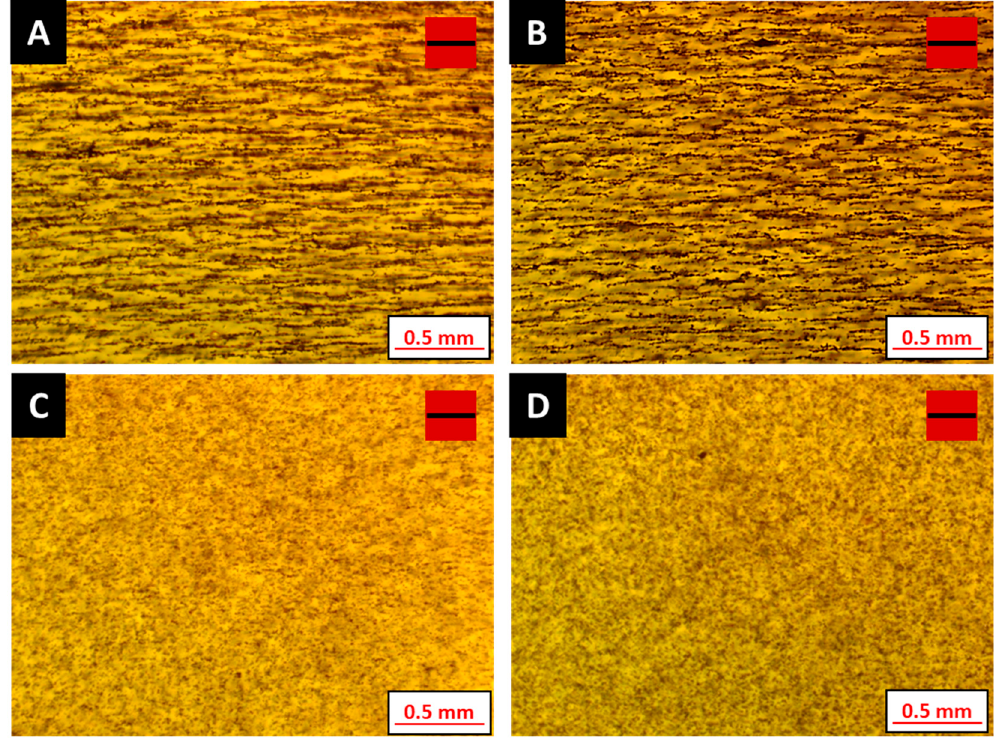
Figure 10. Influence of additive loading on particle alignment ( A , B , C , D refer to suspensions listed in Table 5). Red squares with a black bar indicate the presence and direction of the magnetic field.